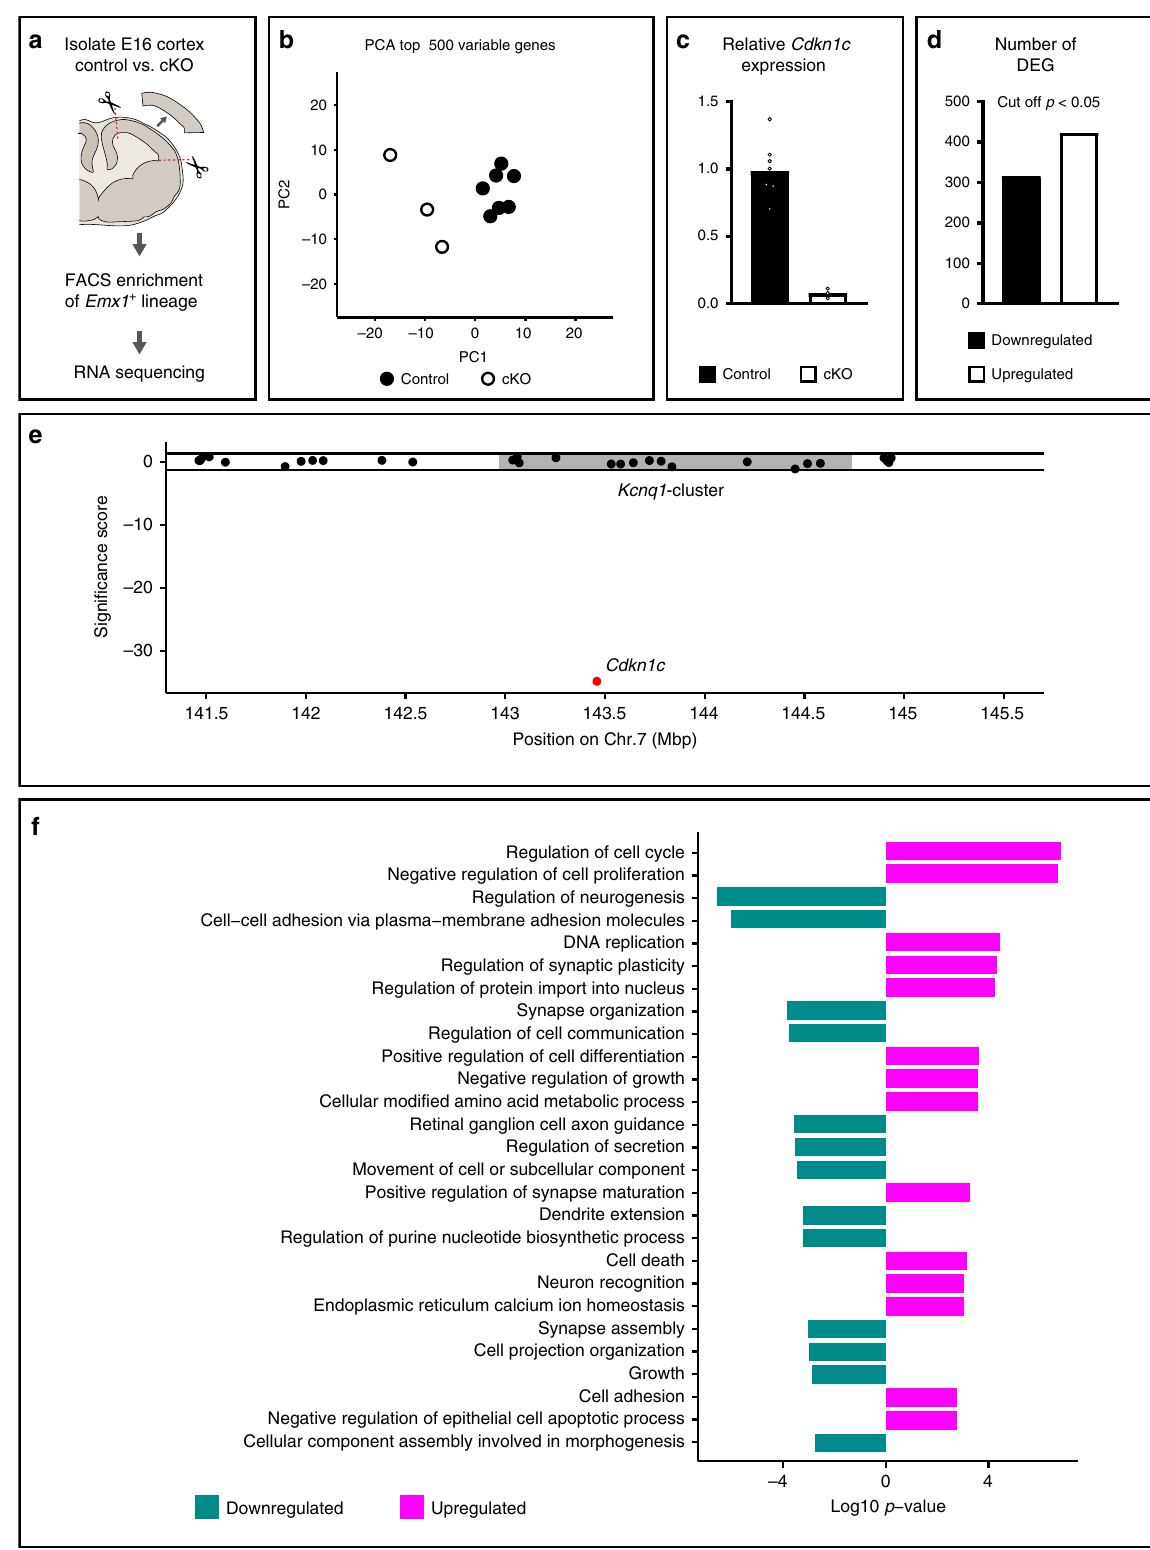
Isolate E16 cortex control vs.